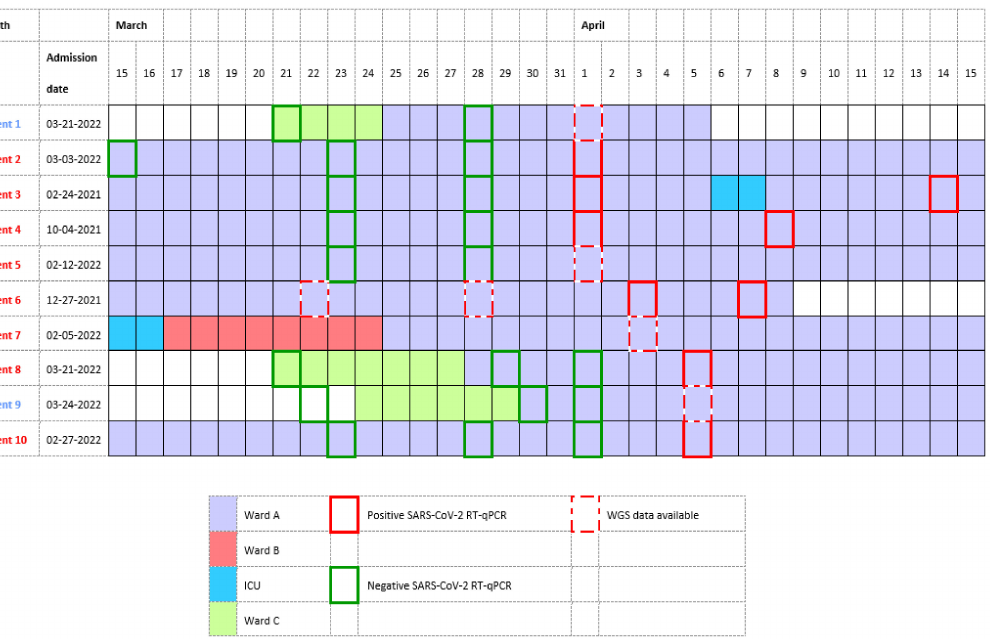
Figure 2. Epidemiological timeline of revalidation ward (ward A) cluster. All patients were admitted for more than seven days before their positive SARS-CoV-2 RT-qPCR NP swab (red box), and all had recent negative tests (green box), except for one (patient 6). WGS data were available for five of these ten patients, including this case patient (red dotted box). The patients mentioned in red are classified as definite HAI and those in blue as probable HAI according to the ECDC case source definitions of